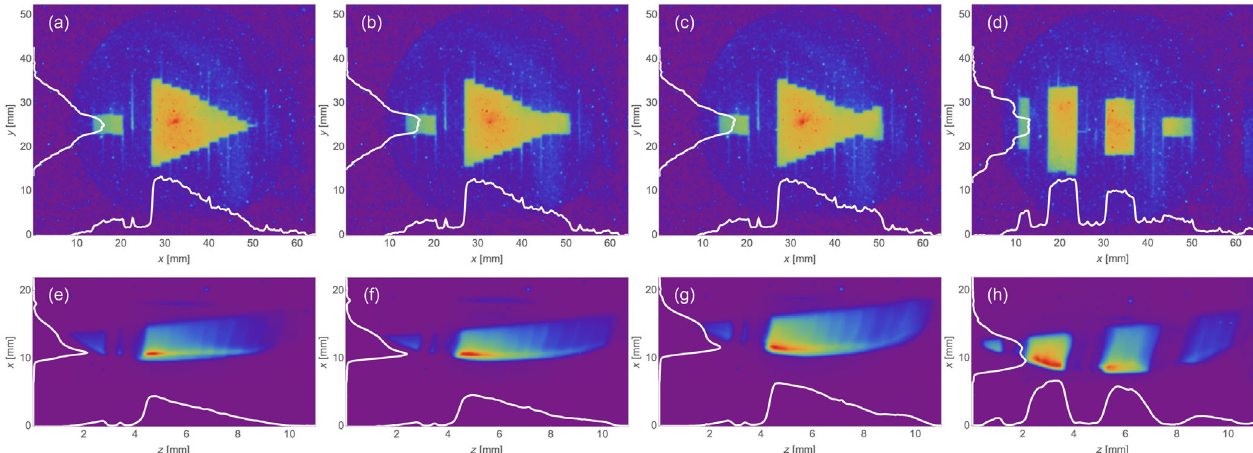
FIG. 6. Screen images with vertical and horizontal projections for four MLC mask configurations. Top row (a – d): electron shadow of the mask 0.28 m downstream of the MLC for drive and witness beam distributions, for triangle, triangle with doorstep, triangle with bowtie, and three bunch profile, respectively. White lines show the transverse projections of the beam. Bottom row (e – h): Beam images after propagating the EEX beamline and a transverse-deflecting cavity, for triangle, triangle with doorstep, triangle with bowtie, and three bunch profile, respectively.